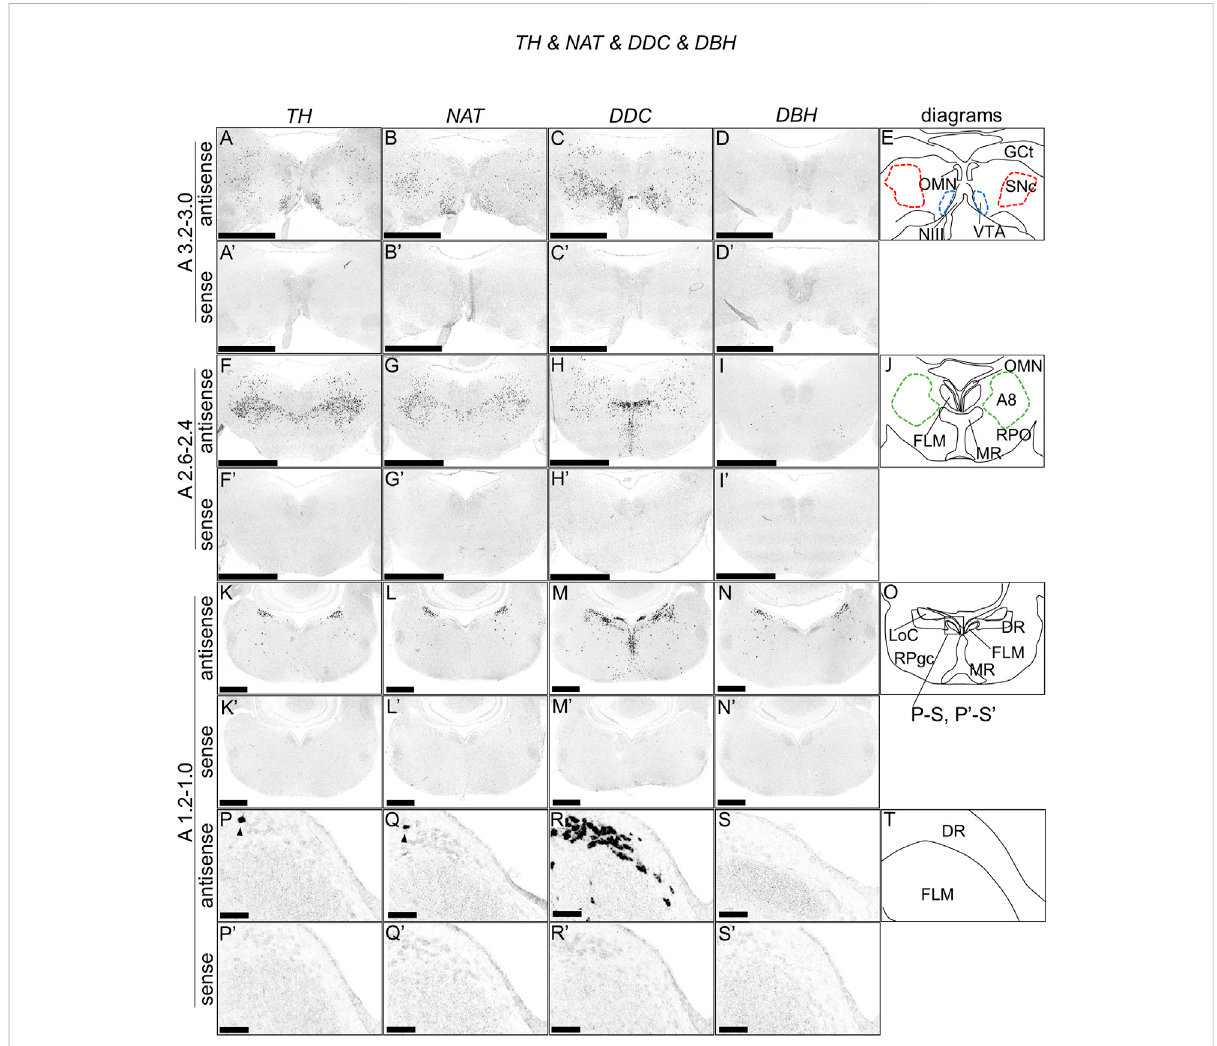
situ hybridization in coronal sections of P1 chick brainstems. To evaluate the expression patterns of TH, NAT, DDC, and DBH , sections of 10 P1 chick brainstemswereanalyzedfor TH ,8for NAT ,7for DDC, and7for DBH. Representativeimagesofthelevelsofexpressioninneighboringsections (A3.2 – 3.0, A2.6 – 2.4, and A1.2 – 1.0) from 3 P1 chick brainstems. (P – S and P 9 – S 9 ) Magni fi ed views of brainstem areas in the box in (O) . The levels of expressioninthesesectionswereinaccordancewiththosementionedintheKuenzelandMasson ’ schickatlas(KuenzelandMasson,1988). (E,J,O,T) Diagrams of coronal sections shown in panels (A), (F), (K), and (P) . Arrowheads indicate signals. A8: A8 cell group; DR, dorsal raphe; FLM, fasciculus longitudinalis medialis; GCt, griseum centrale; LoC, locus coeruleus; MR, median raphe; NIII, nervus oculomotorius; OMN, oculomotor nucleus;